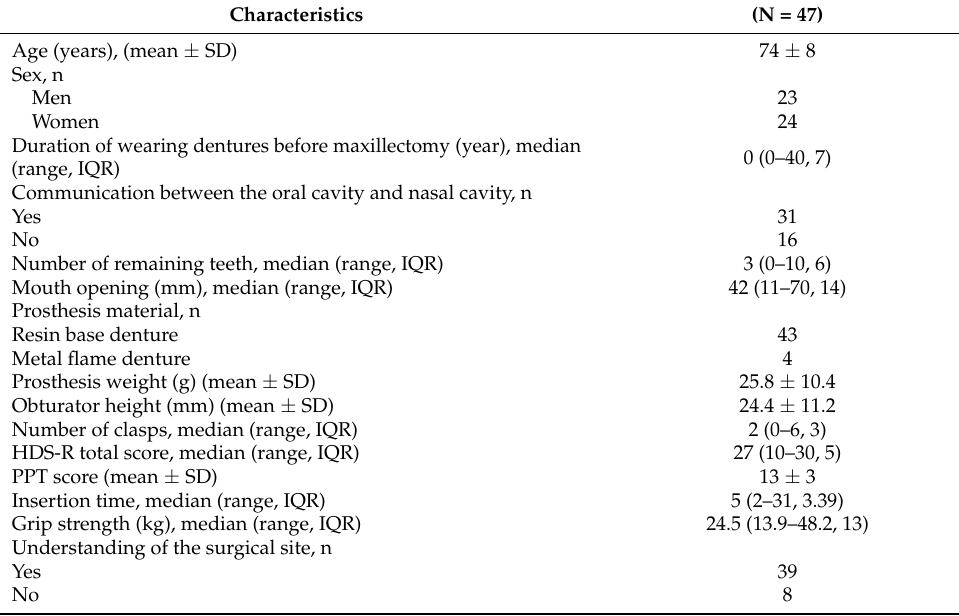
Table 5. Characteristics of the